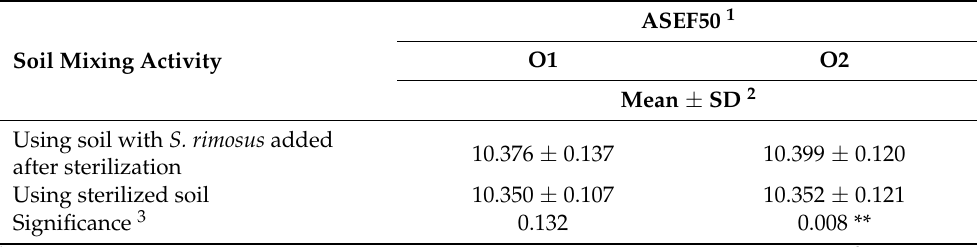
Table 2. Results of the spectral edge frequency 50% of alpha (ASEF50) by electroencephalography, according to the presence and absence of Streptomyces rimosus (S. rimosus) in the soil during the soil mixing